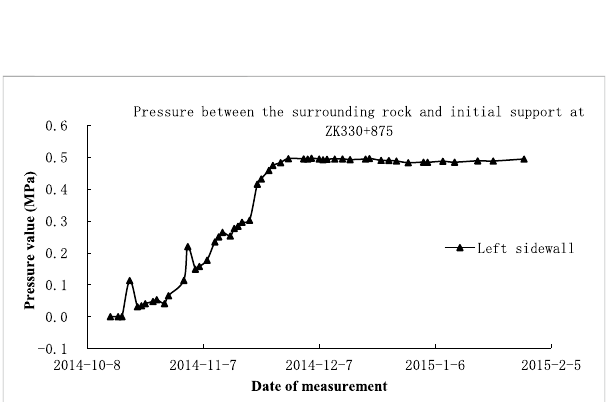
FIGURE 12 Relationshipbetweenthevaultsettlementandburialdepthofthe left portal of the Jiangluling Tunnel.